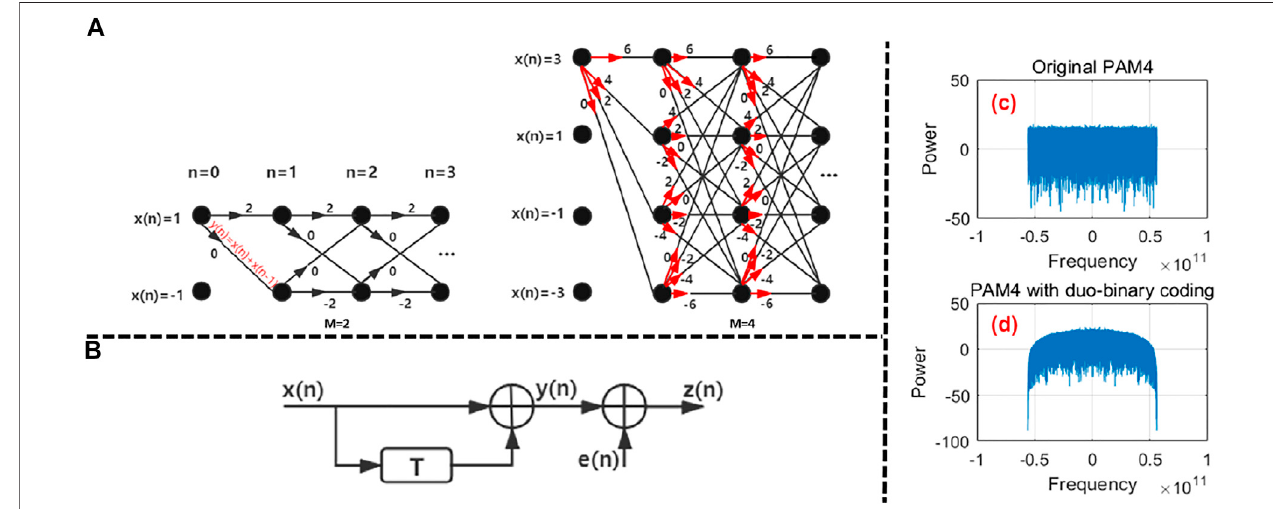
FIGURE 1 | (A) Duo-binary signal frame diagram of M-PAM, (B) simpli fi ed channel model of Duo-binary pulse shaping, (C) spectrum of 4-PAM signal, and (D) spectrum of duo-binary 4-PAM